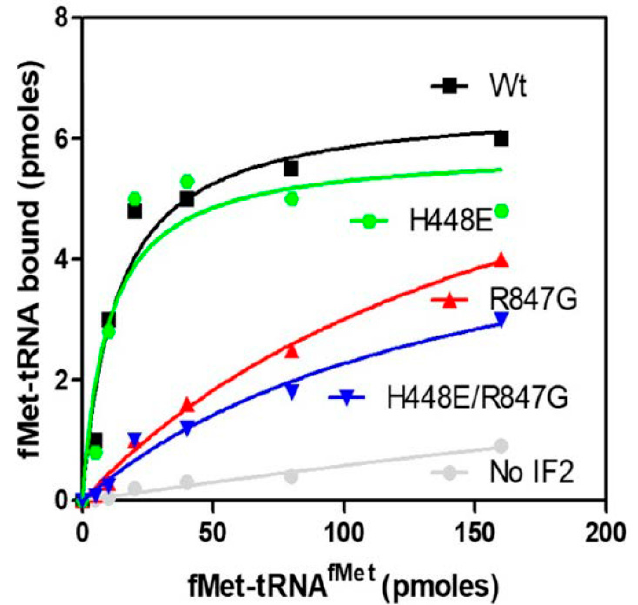
Figure 4. Formation of 30S IC in the presence of IF2 wt and IF2 mutants. The amounts of fMet-tRNA bound to 30S ribosomal subunits programmed with 022 mRNA in the presence of IF1, IF3 and of purified IF2 wt (black), IF2 R847G (red), IF2 H448E/R847G (blue), and IF2 H448E (green) were measured after 15 min incubation at 37 °C as a function of increasing amounts of initiator tRNA offered. The experimental conditions are the same as indicated in the legend of Figure 5.